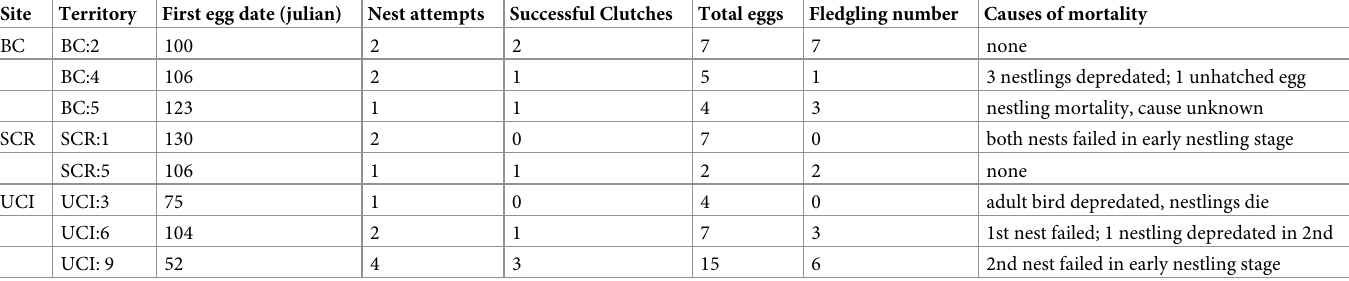
Table 1. Outcome of Coastal Cactus Wren nesting efforts across territories monitored in 2012. Productivity was tracked among territories in terms of the date that the first egg was laid, the total number of nesting attempts, eggs laid, fledgling success, and the timing and causes of nesting failure. Site